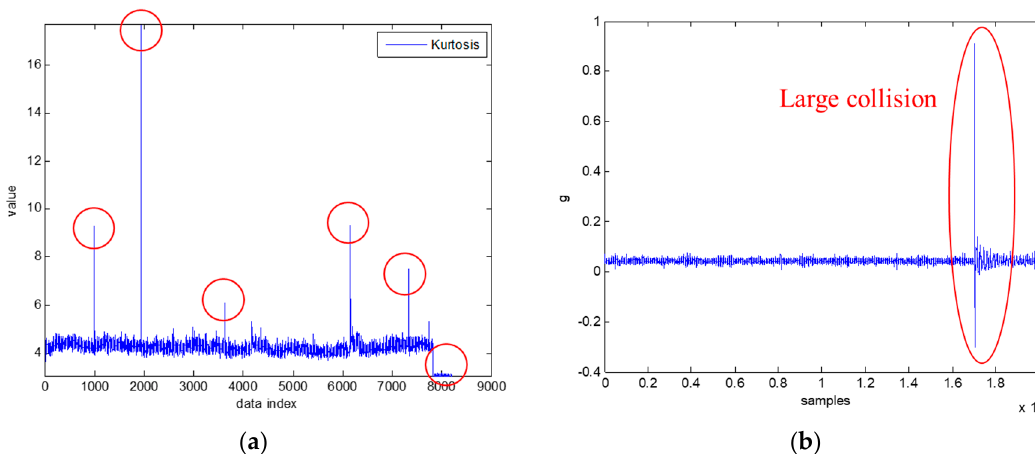
Figure 14. Data clearing illustration. ( a ) Kurtosis (abnormal data). ( b ) Raw signals.